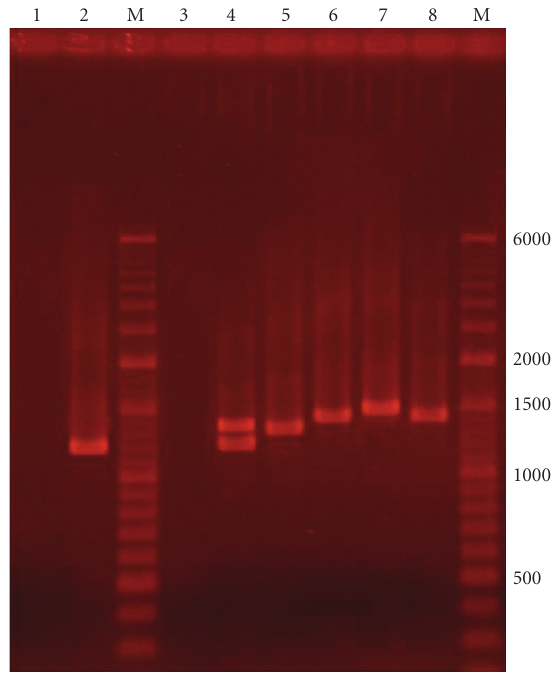
Figure 1: The pattern of bands of spa gene in S. aureus isolated in north of Iran. M: mark for DNA Ladder (6000 bp with a 100bp to 1500 bp, Company Fermentas). Number 1 is negative and 2 positive control (Col strain), respectively. Number 3 and 4 are the strains of Staphylococcus aureus without spa band and two bands of spa gene and numbers 5–8 are strains of Staphylococcus aureus with one band of spa